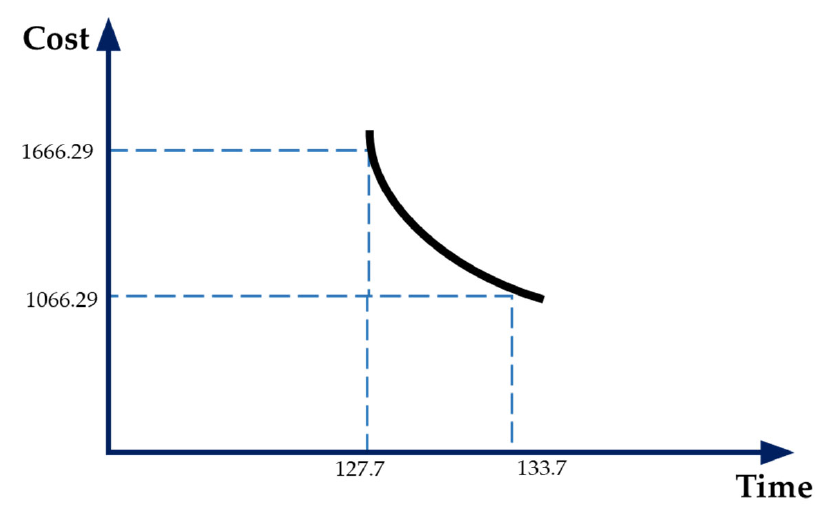
4 Table 16. Evaluation index for each failure mode after improvement. Failure Mode